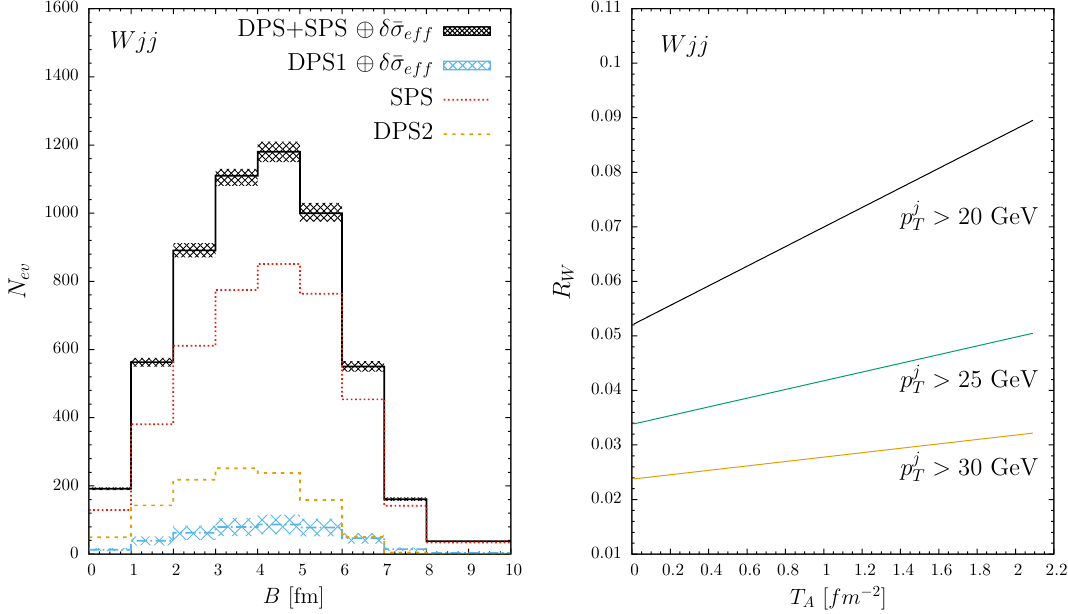
(cid:4) > 30 GeV (left). The ratio R L dt = 0 . 1pb − 1 and for p j T